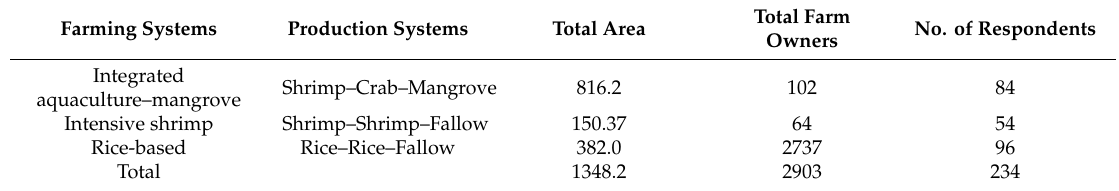
Table 1. Distribution of land and owners according to di ff erent systems in the study